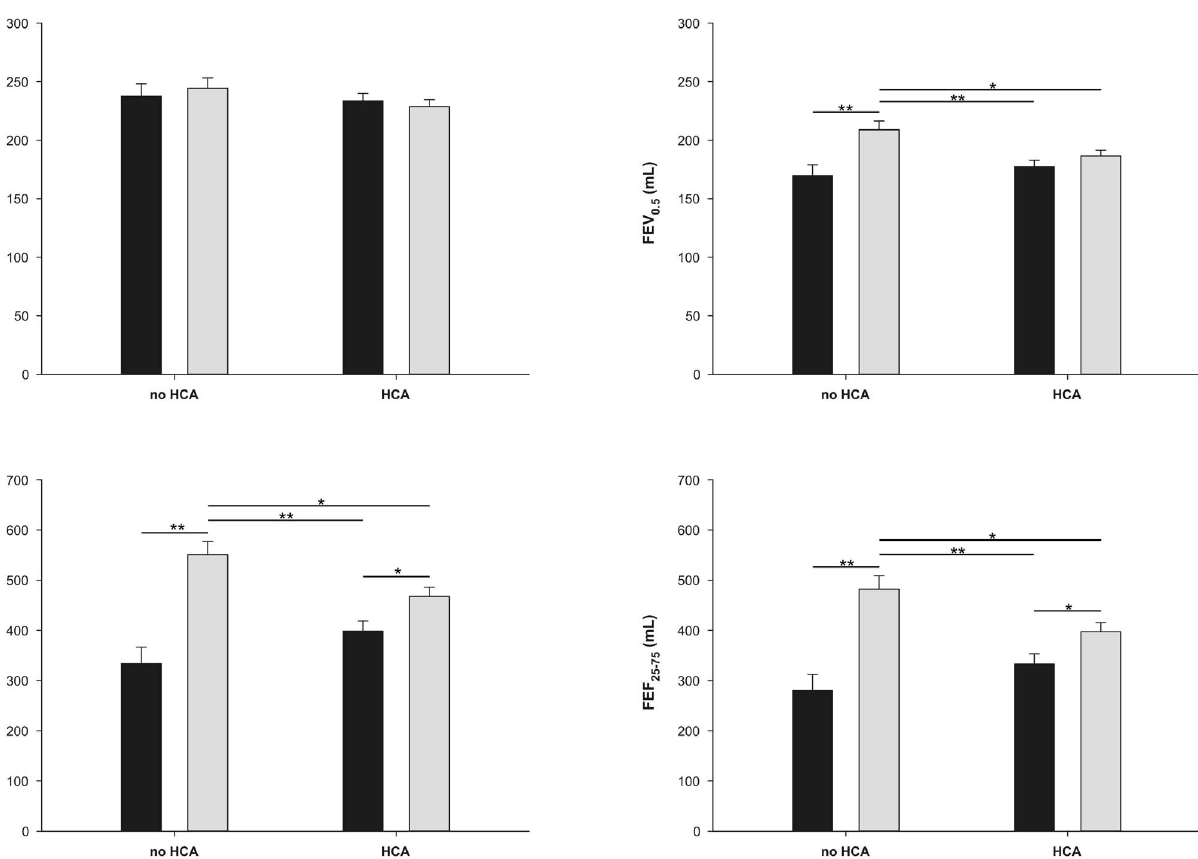
Lung function, Weight/age, and Length/age expressed in Z scores. Data are mean 6 SD. *p , 0.05; **p , 0.01; for Mann-Whitney Test for continuous variables between male versus female preterm infants and between None versus HCA Grade 1 and HCA